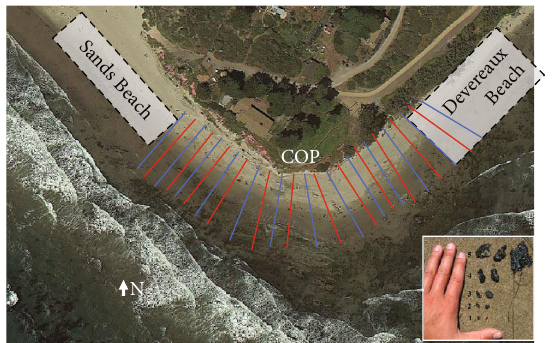
Figure 27: Location of transects 1-12 for COP and coverage by 2 m quadrats as used in beach tar surveys. Inset: example images of tar ball size classes